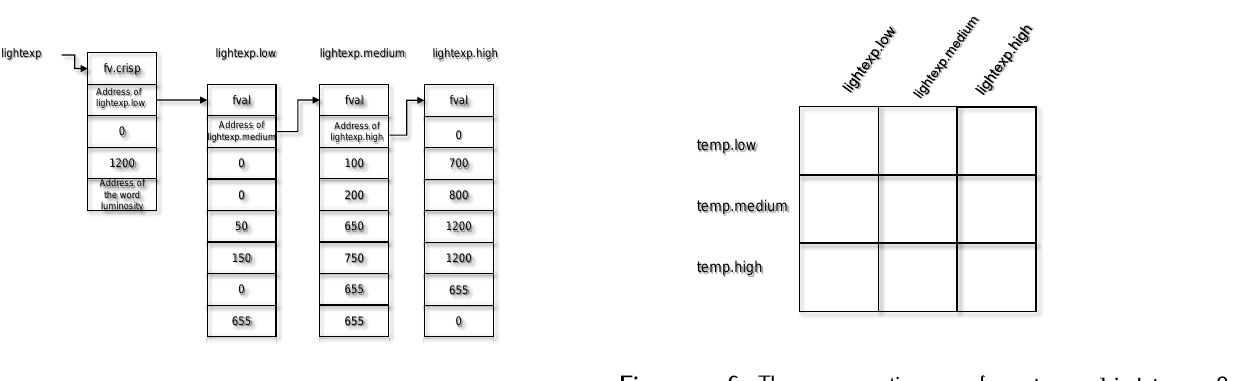
Figure 5. Memory representation of the fuzzy variable lightexp and its related membership functions after the code shown in Figure 4 is executed. The implementation refers to linked structures. Each link field stores the address of the next defined membership function. A link field that is equal to zero indicates the last membership function concerning that variable. It is worth noticing that the slope values are “scaled" to 65535 since this is the maximum number that can be expressed with 16-bits.